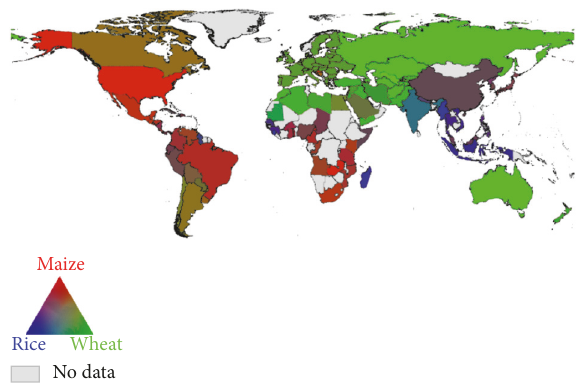
Figure 1: Global major grain consumption map . Source : New England Complex Systems Institute, 2011, and Bar-Yam et al. [12, 13]. Note . Colors represent the relative domestic consumption of corn, rice, and wheat in each country or indicate that no data is